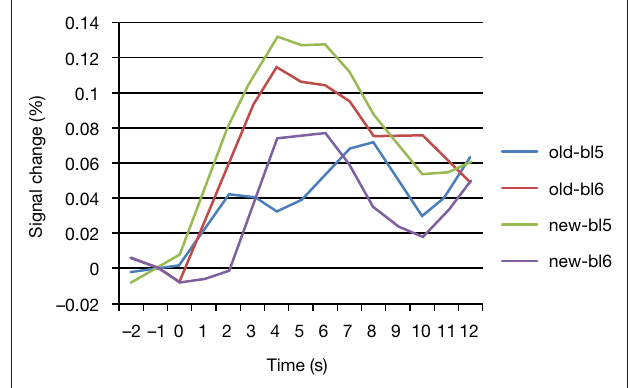
FIGURE 6 | BOLD curves for frontopolar cortex as a function of condition and block. Curves represent the average event-related signal for old and new trials after subtraction of the null-event curves. Bl5/6: block